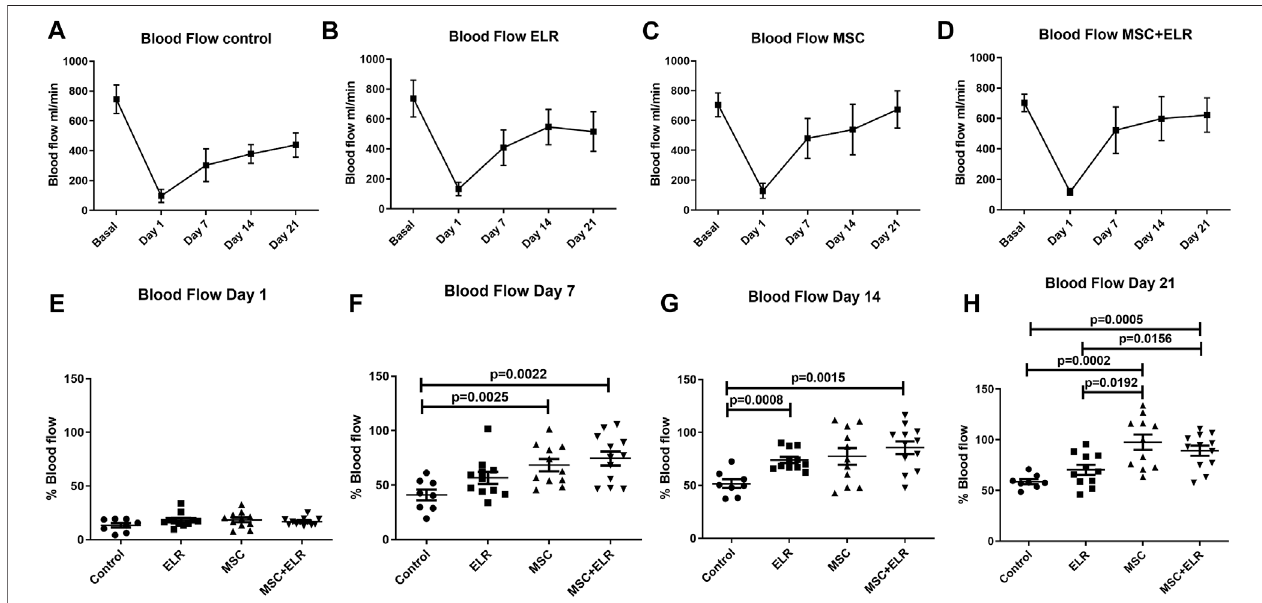
FIGURE 1 | Evolution of tissue reperfusion after femoral artery ligation in CD1 mice. Representative lineal graphs of blood fl ow of (A) control ( n = 8), (B) ELR biomaterial ( n = 11), (C) MSC (n = 11), and (D) MSC + ELR ( n = 12) groups. Percentage of perfusion vs. basal perfusion at days 1 (E) , 7 (F), 14 (G), and 21 (H) post surgicalinterventionvs.basalblood fl owarerepresentedineachexperimentalgroup.Datarepresentthemean±SEMoffourindependentexperiments.ELR:elastin-like recombinamer; MSCs: mesenchymal stromal